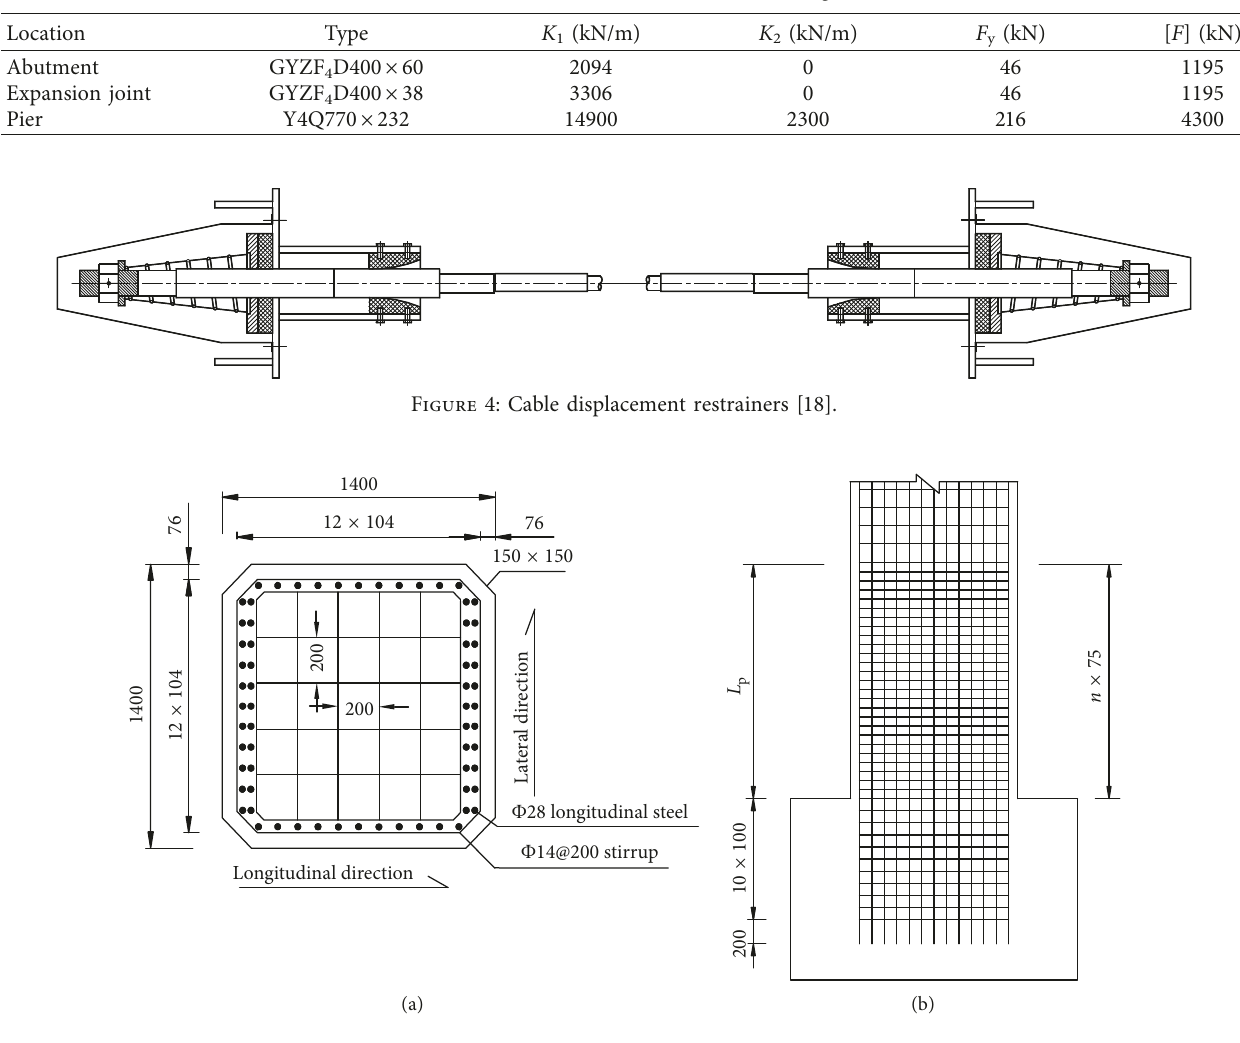
Figure 5: Arrangement of steel bars in bridge columns (unit: mm). (a) Arrangement of steel bars in the section. (b) Arrangement of steel bars in the mesh area with length L p .